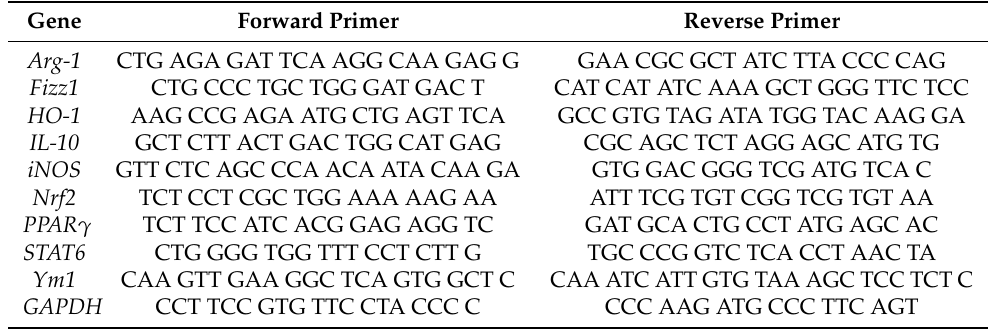
Table 1. List of qRT-PCR primer